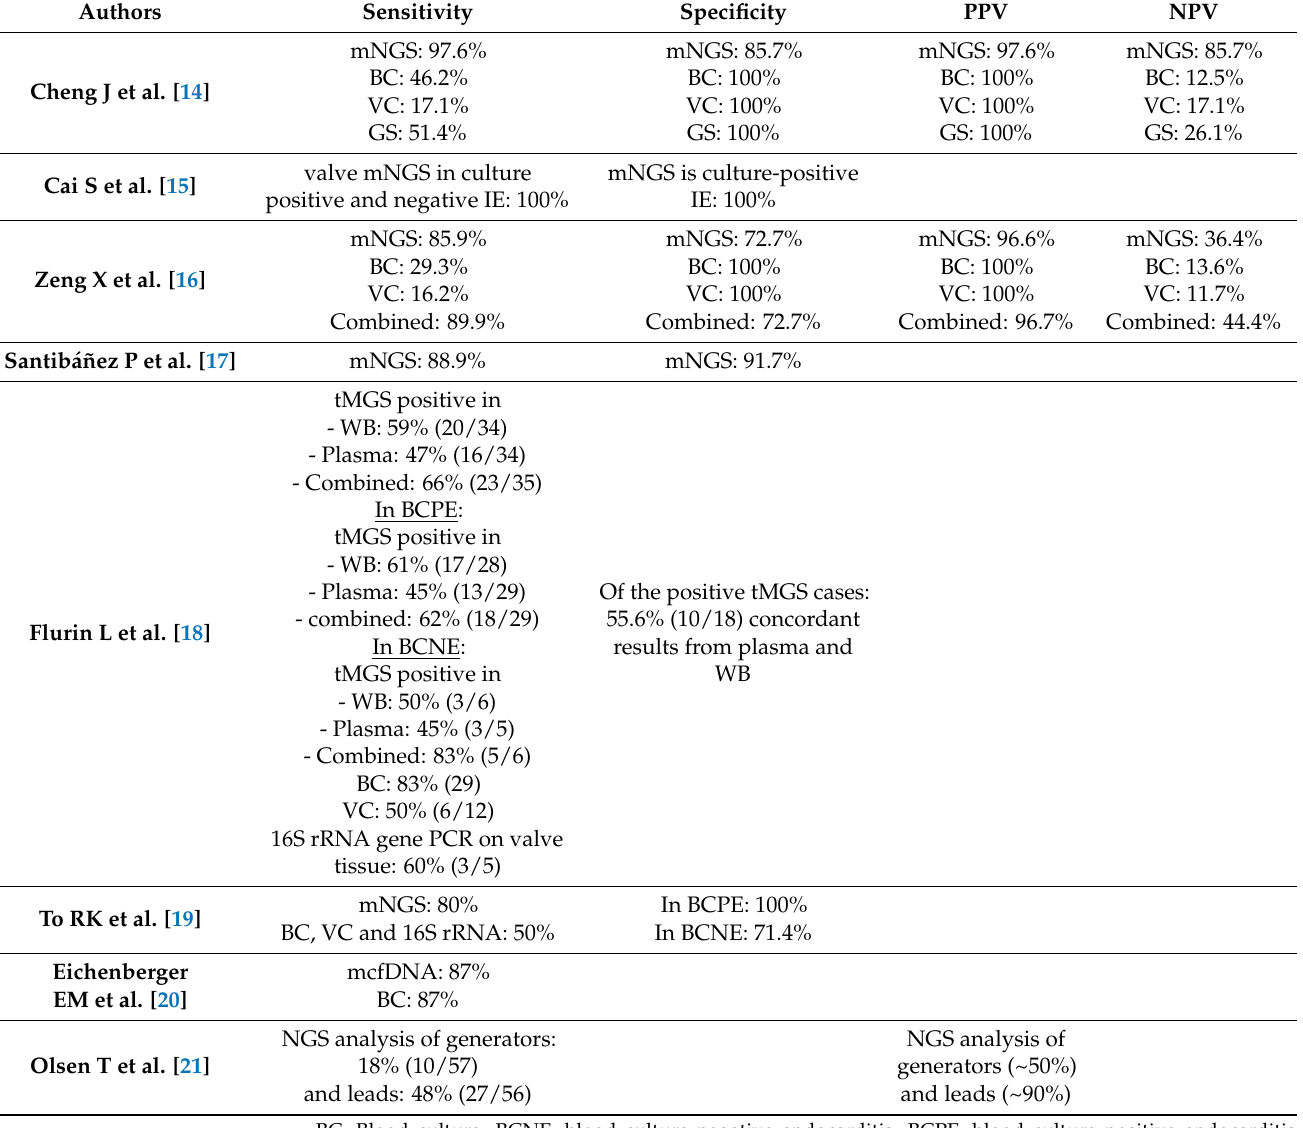
Table 2. Comparison of sensitivity, specificity, positive and negative predictive values between metagenomic next generation sequencing and conventional diagnostic